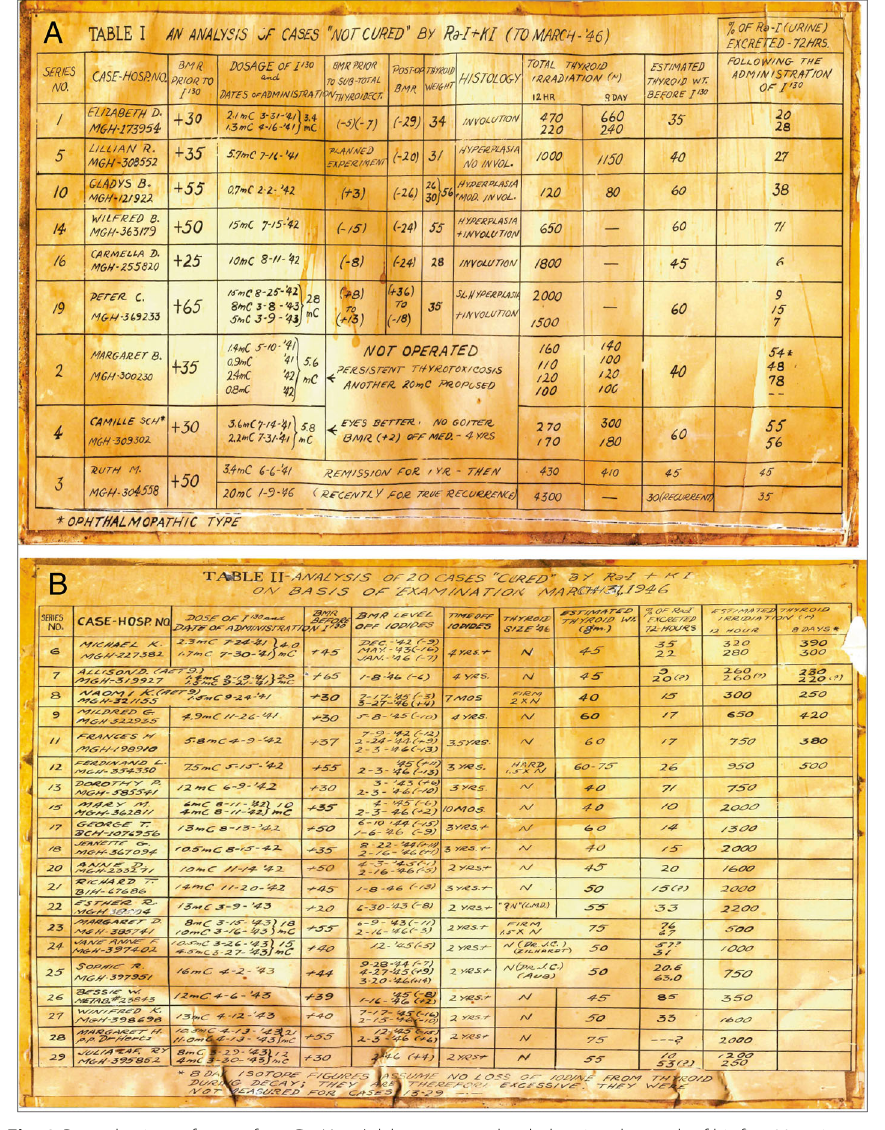
Fig. 3 Reproductions of pages from Dr. Hertz ’ s laboratory notebook showing the result of his first 29